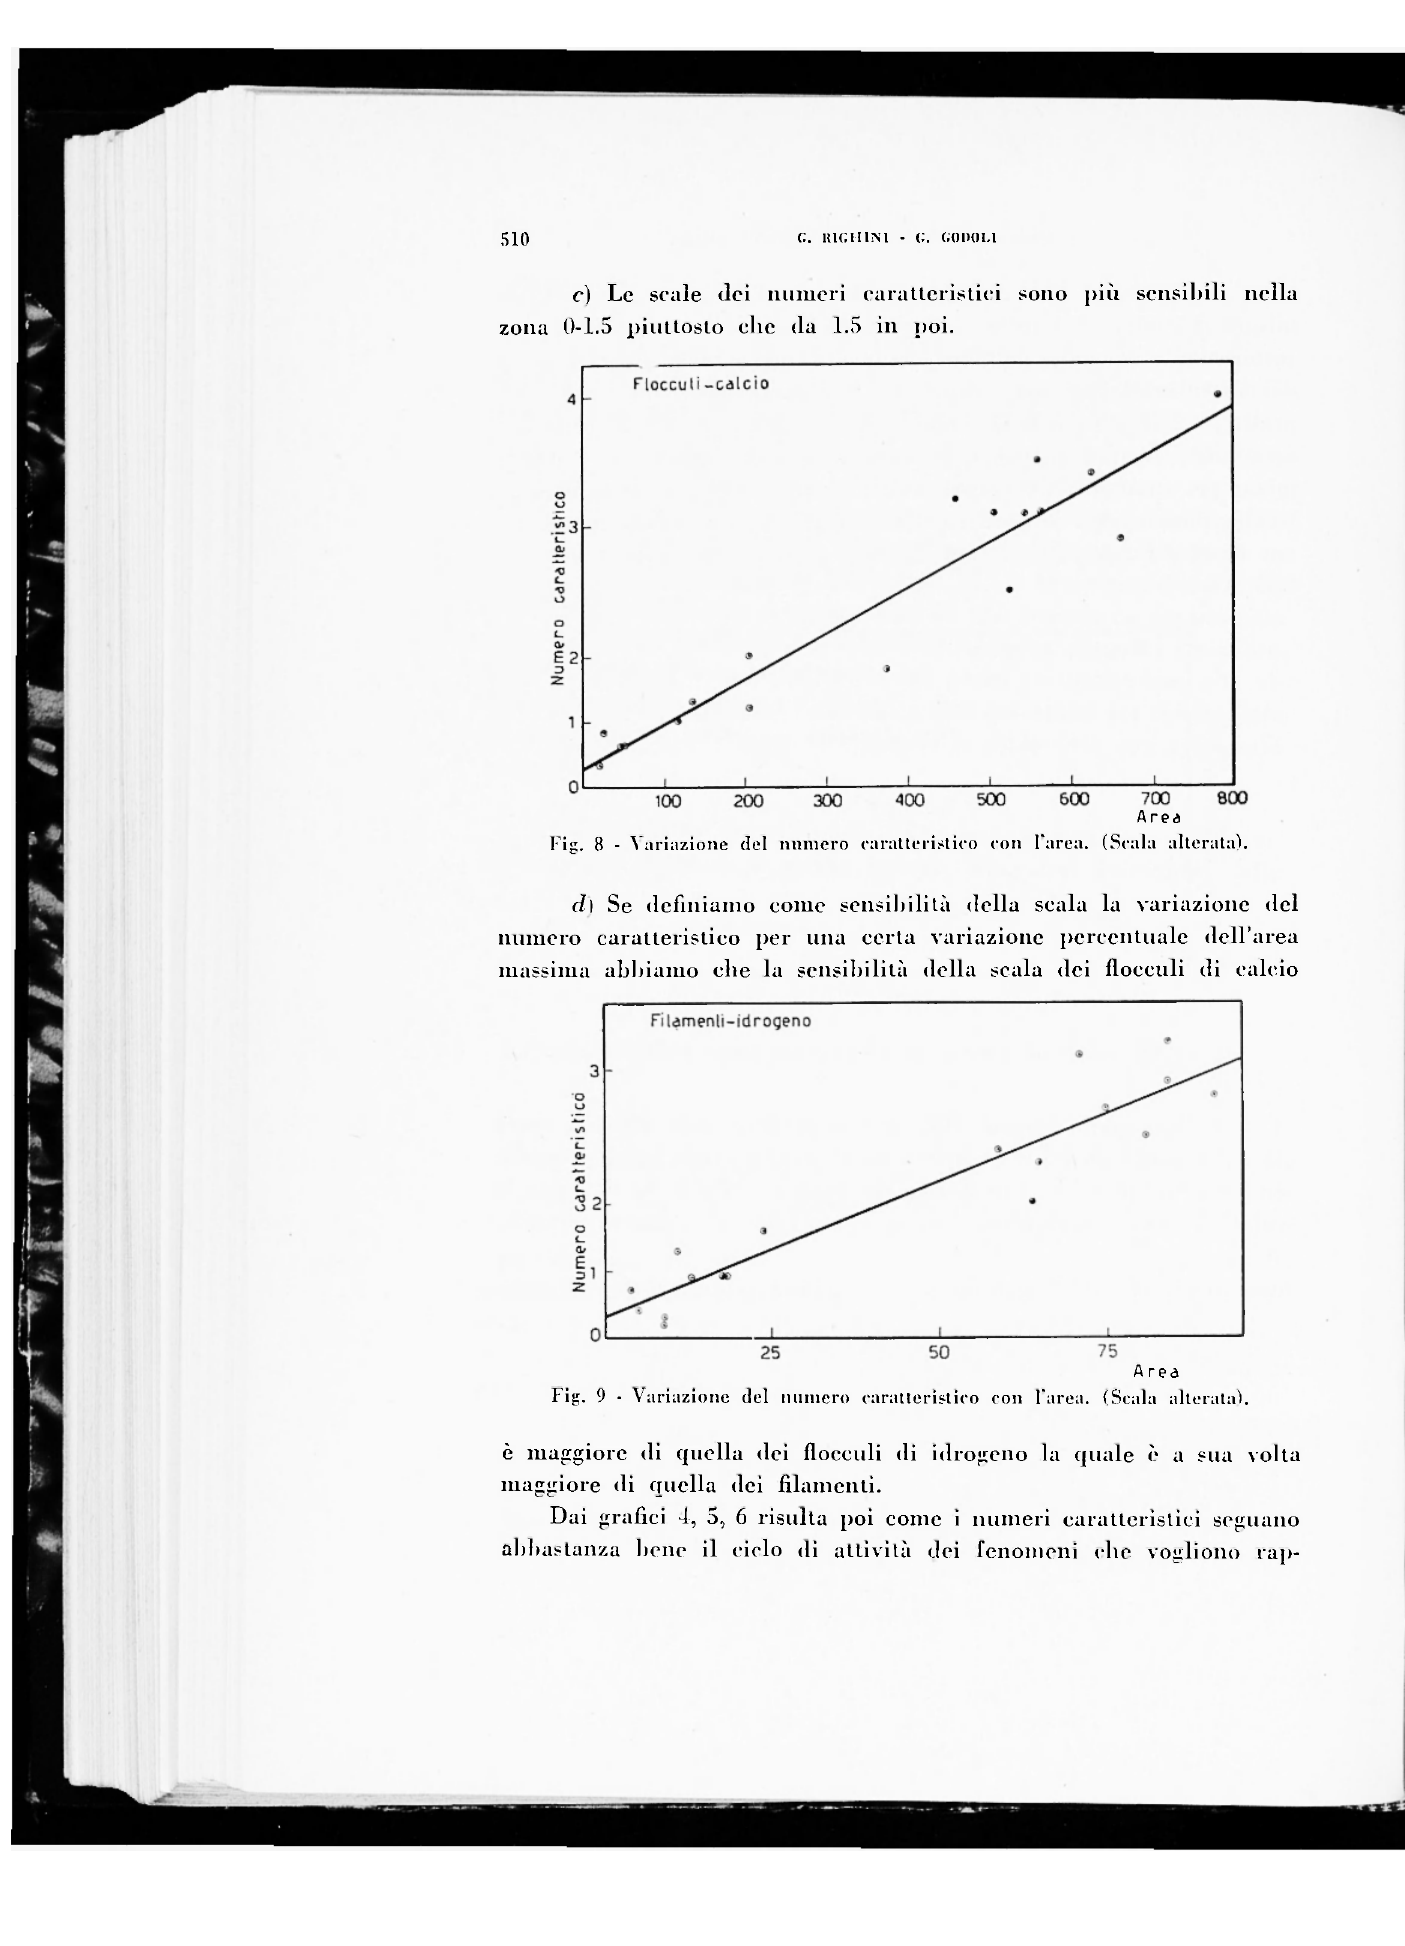
Fig. 9 • Variazione del numero caratteristico con l'area. (Scala